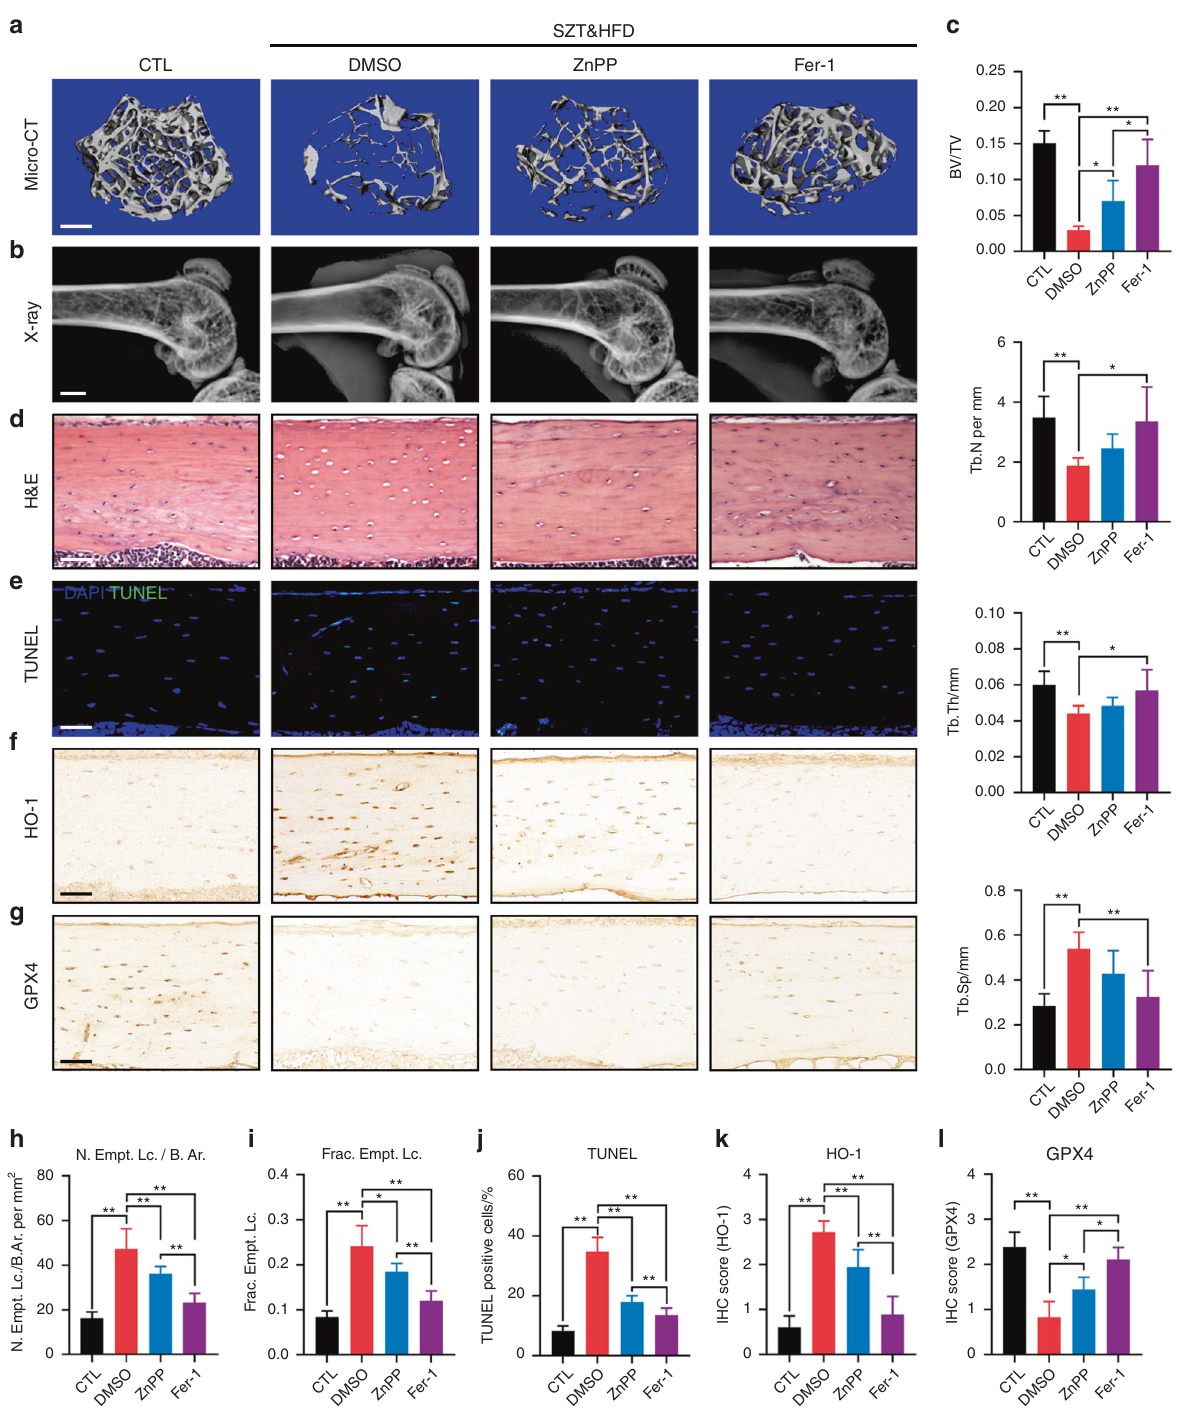
Fig. 7 Targeting ferroptosis rescued DOP and osteocyte death in diabetic mice. a , b Representative micro-CT (scale bar: 300 μ m) and X-ray (scale bar: 2 μ m) images showing the microarchitecture of the distal femur. c Quantitative analysis of the micro-CT parameters. d H&E staining of tibial paraf fi n sections showing empty lacunae (scale bar: 50 μ m). e TUNEL assay of tibial paraf fi n sections showing dead osteocytes (scale bar: 50 μ m). f , g Tibial paraf fi n sections stained for HO-1 and GPX4 (scale bar: 50 μ m). h , i Quantitative analysis of the number of empty lacunae with respect to the bone area (N. Empt. Lc./B. Ar.) and the fraction of empty lacunae (Frac. Empt. Lc.) based on H&E staining. j Quantitative analysis of TUNEL-positive cells based on a TUNEL assay. k , l Quantitative analysis of HO-1 and GPX4 expression in vivo based on IHC staining. * P < 0.05; ** P < 0.01. Each group contained six DFO, Fer-1 displays better rescue effects. Moreover, unlike other Fer-1 rescue group. Notably, Fer-1 works in a paracatalytic manner cell death inhibitors that target speci fi c proteins in signaling and is not consumed as it inhibits lipid peroxidation. In contrast to Fer-1, DFO is an iron-chelating agent that inhibits ferroptosis by binding to intracellular free labile iron. Therefore, compared with